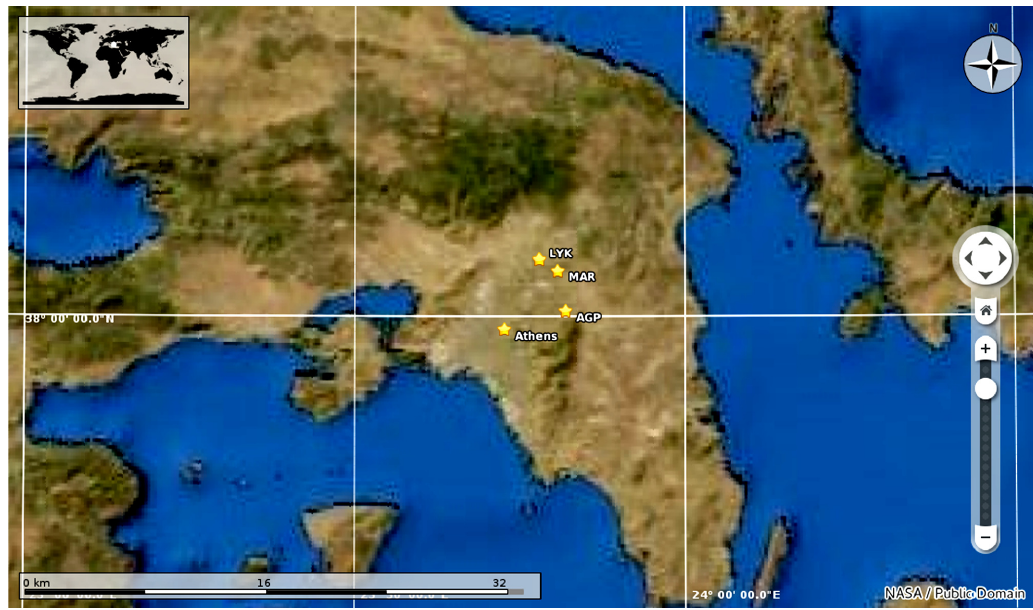
Figure 1. Map of Greece focusing on the greater Athens area, indicating the location of the Lykovrissi (LYK), Maroussi (MAR), and Agia Paraskevi (AGP) air-pollution monitoring